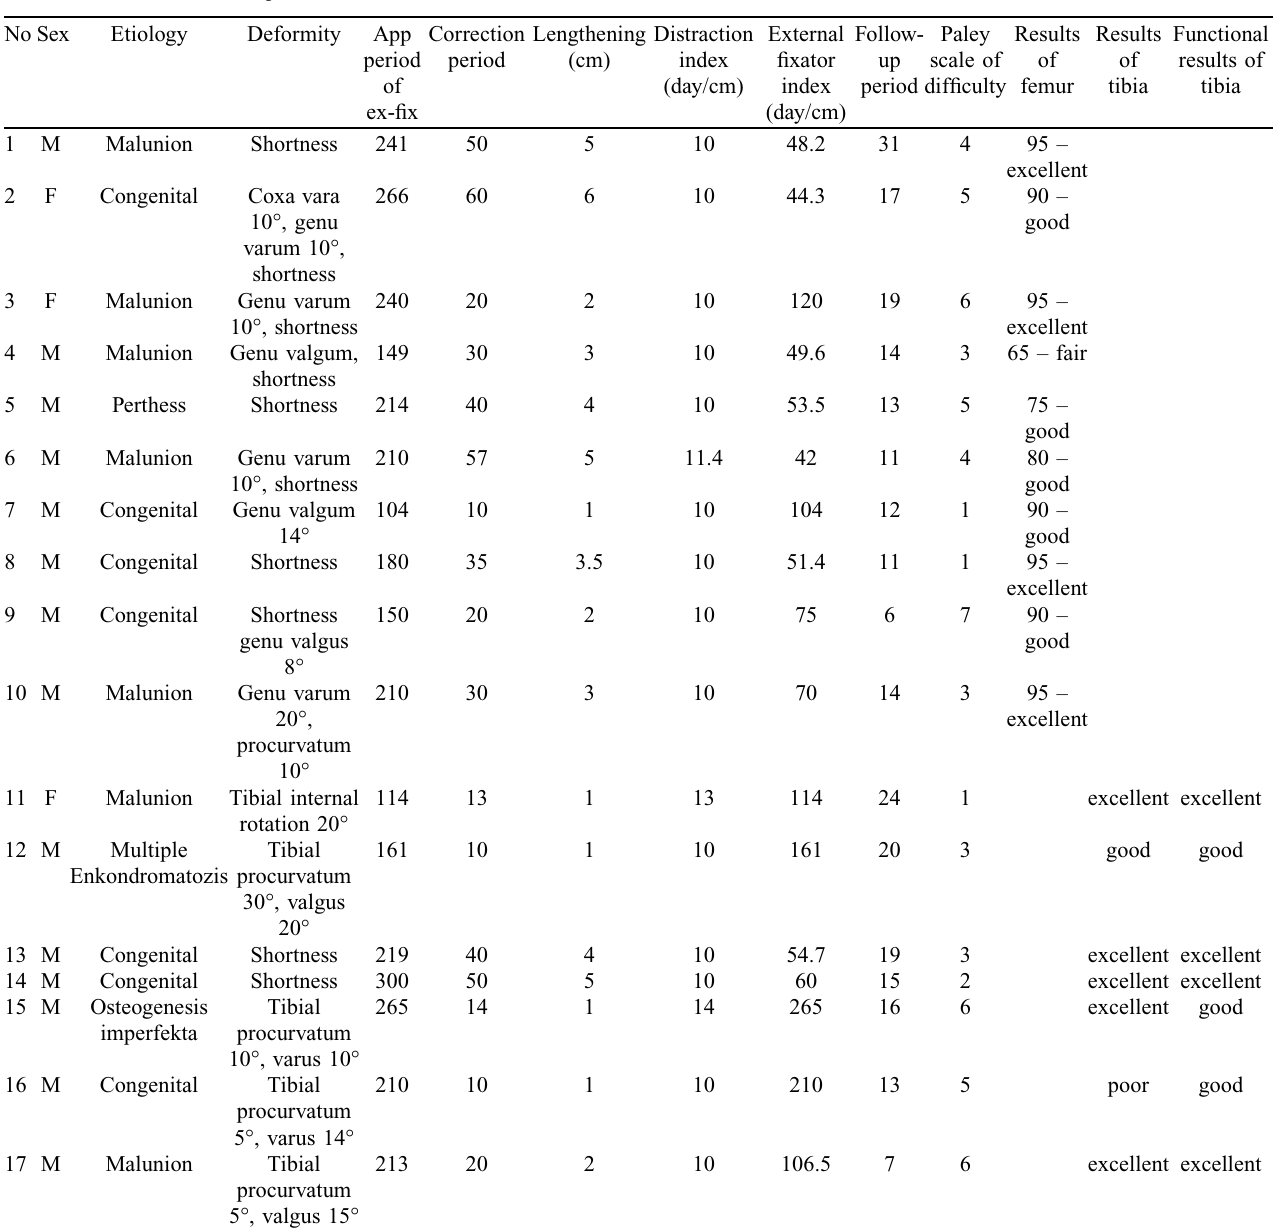
Table 1. Master table of all